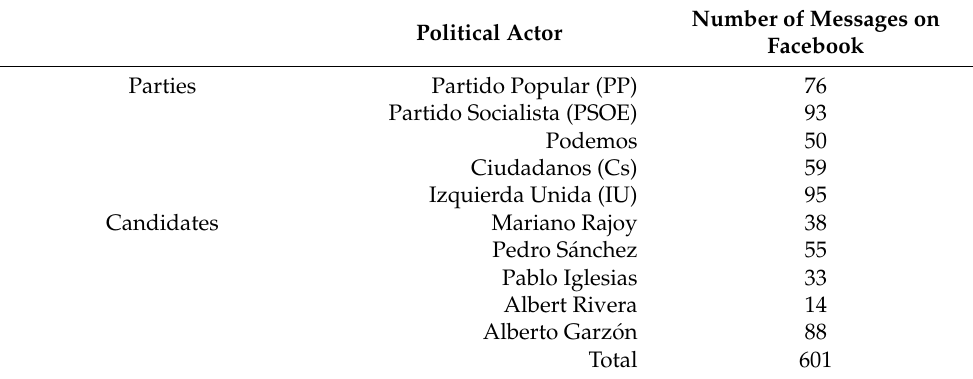
Table 1. Distribution of the Analysis